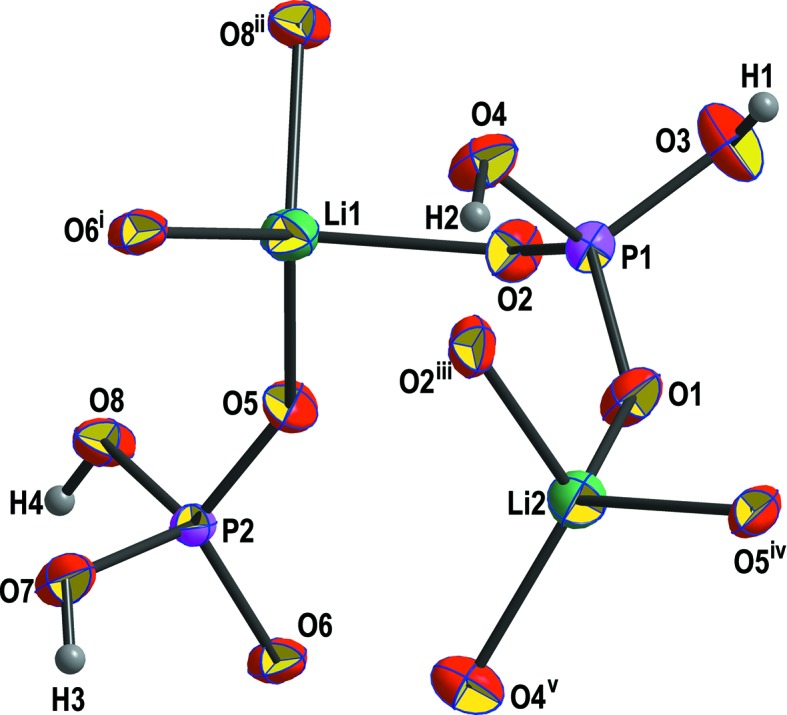
The principal building unit of Li2(H2PO4)2, shown with displacement ellipsoids at the 70% probability level. The symmetry codes are as defined in Table 7 ▸.